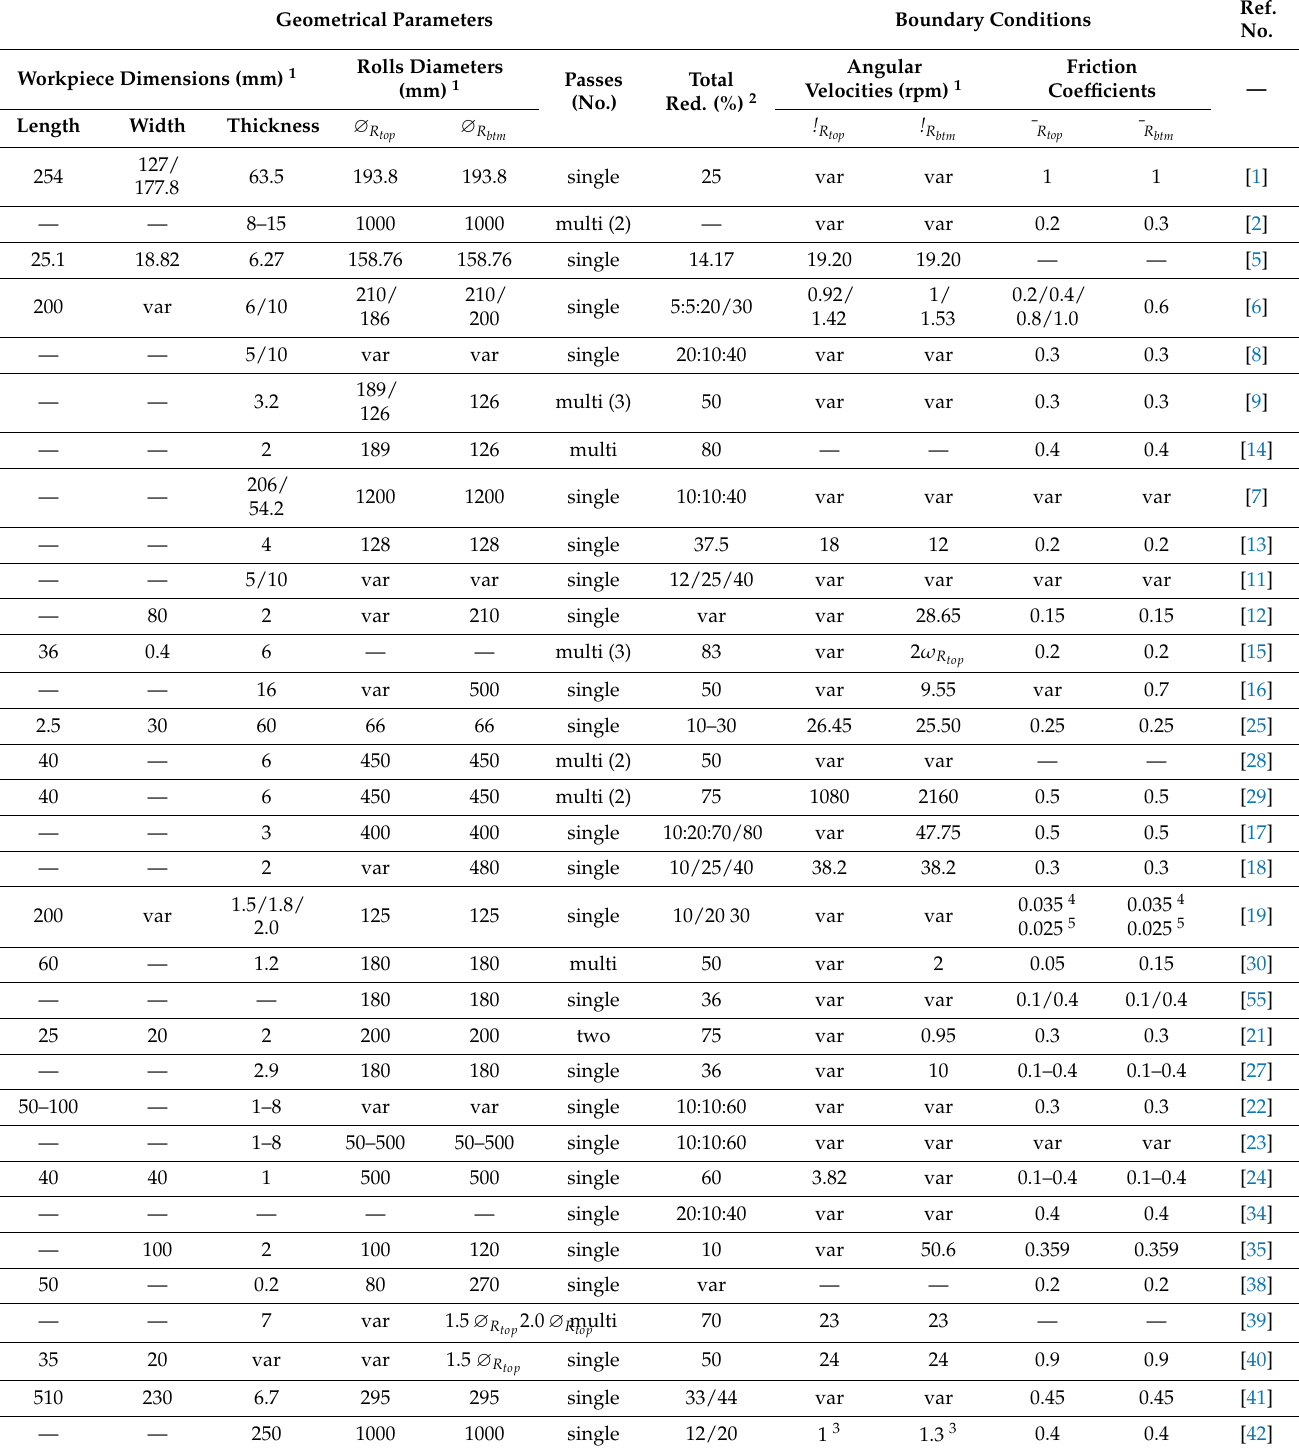
Table 1. Geometrical model parameters used in ASR simulations by different